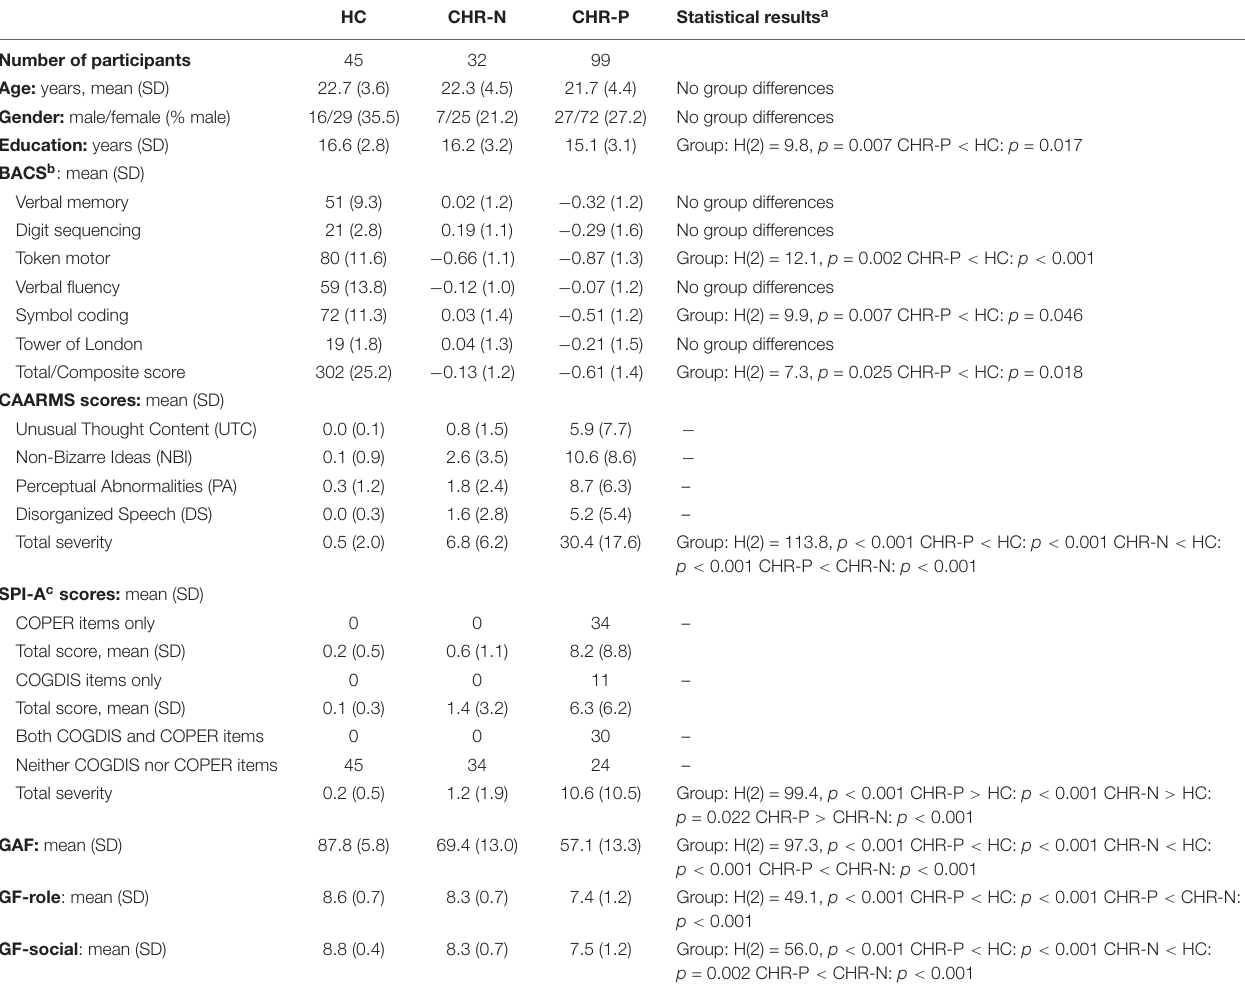
TABLE 2 | Demographic, general cognition, and clinical assessment data. HC CHR-N CHR-P Statistical results